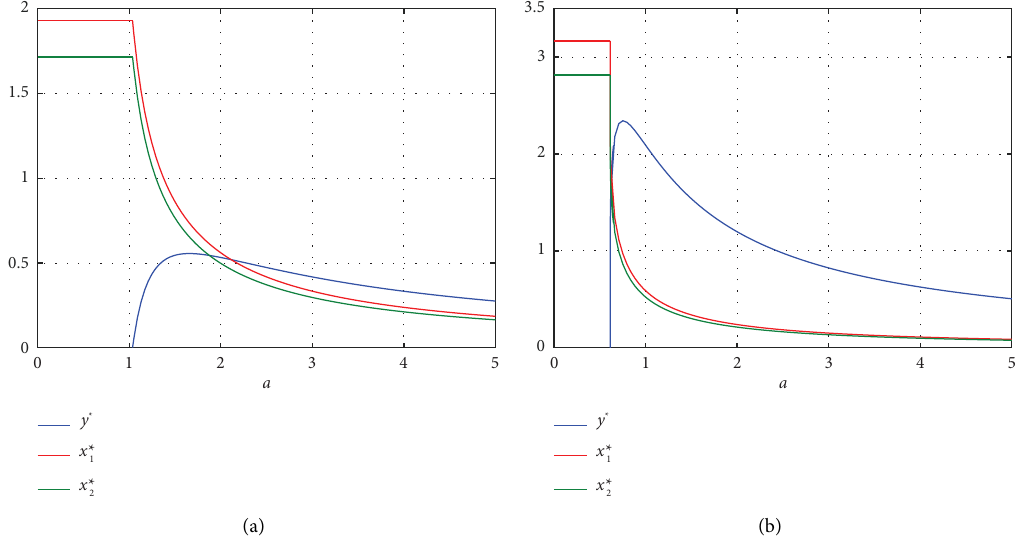
, μ , p,c ) � ( 1 , 0 . 1 , 0 . 8 , 0 . 5 ) : (a) F � 5 and 1 2